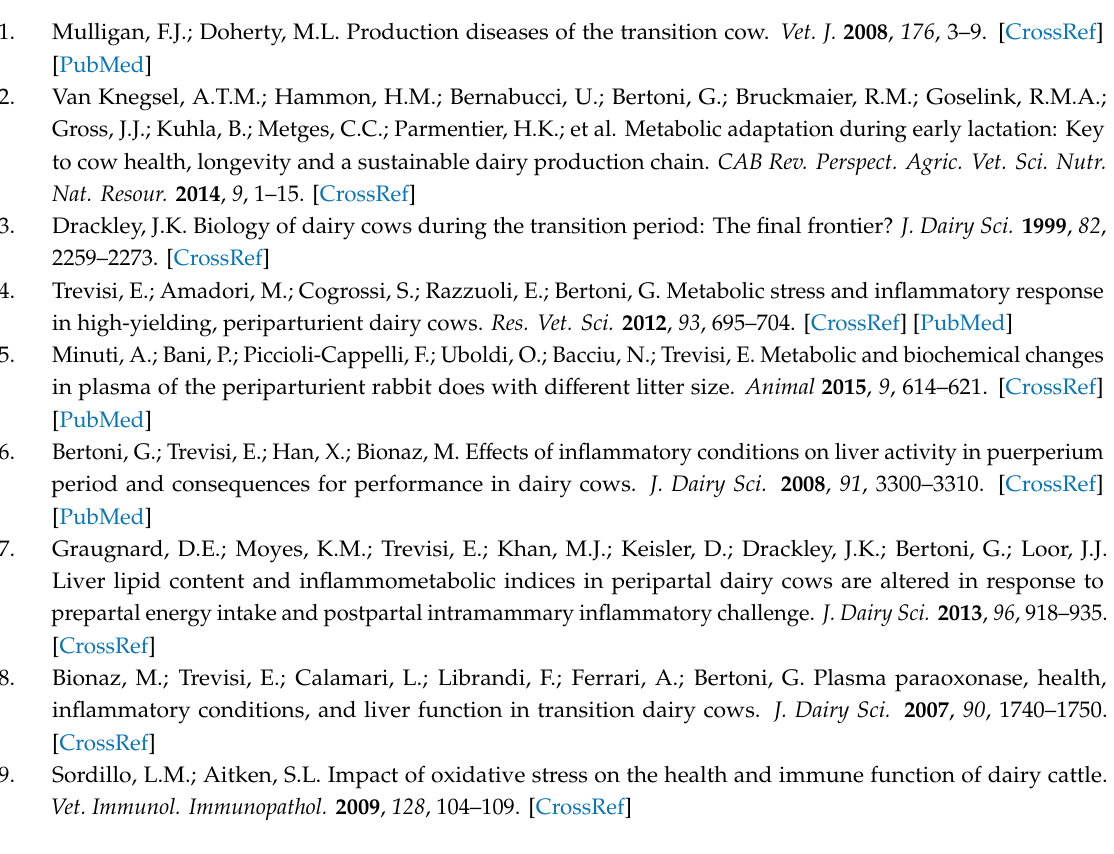
Table S1: Intra- and inter-assay coe ffi cient of variations, limit of quantification (LOQ), codes of commercial kits used and references for their validation in the bovine plasma for plasma parameters included in the study. Figure S1: Pattern of plasmatic concentrations of glucose (a), beta hydroxybutyrate (b), glutamate-oxaloacetate transaminase (AST-GOT; (c) and bilirubin (d) expressed as their original values in dairy cows receiving placebo water (CTR; black dotted line) or cows receiving a drench of 200 g / d of Aloe arborescens Mill. whole plant homogenate between − 14 and 14 days from calving (AAM; green solid line). DFC is days from calving. Figure S2: Pattern of plasmatic concentrations of glucose (a), beta hydroxybutyrate (b), glutamate-oxaloacetate transaminase (AST-GOT; (c) and bilirubin (d) expressed as their original values in dairy cows receiving placebo water (CTR; black dotted line) or cows receiving a drench of 200 g / d of Aloe arborescens Mill. whole plant homogenate between − 14 and 14 days from calving (AAM; green solid line). DFC is days from